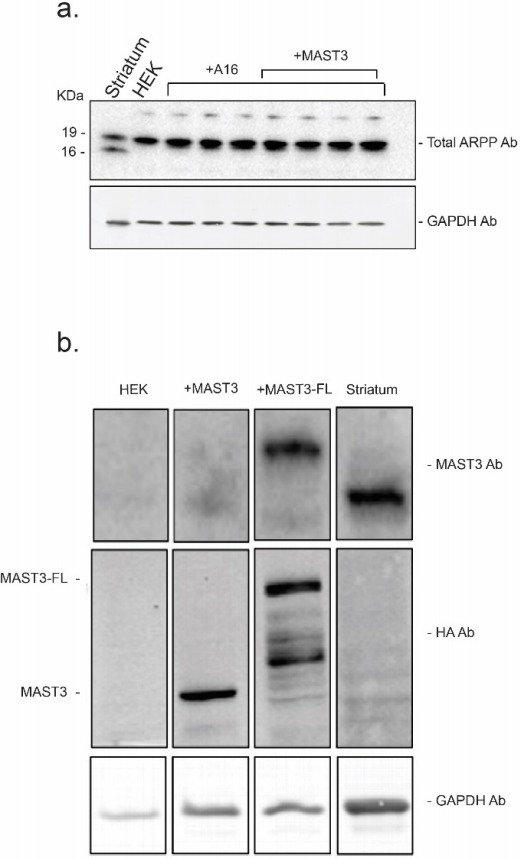
The expression levels of endogenous ARPP-16 (panel a.) and MAST3 (panel b.) in striatum were compared to ARPP16-HA, MAST3-HA (a shorter form of MAST3 used in the studies described in the manuscript) and full length MAST3-FL-HA recombinant proteins expressed in HEK293 cell.Protein expression was measured by serial immunoblotting using an antibody against MAST3 (to detect endogenous protein in striatum and cells overexpressing MAST3-FL-HA) and an antibody against the HA tag (to compare the levels of MAST3-HA and MAST3-FL-HA). Immunoblots were carried out in a similar range of protein amounts and protein levels were normalized to GAPDH.